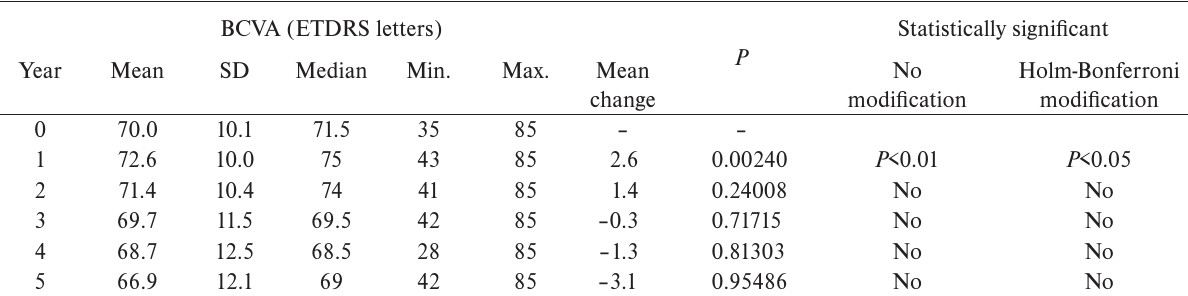
Table 2. Best corrected visual acuity (BCVA) (ETDRS letters), 5-year long monitoring and evaluation of the change BCVA from the beginning.